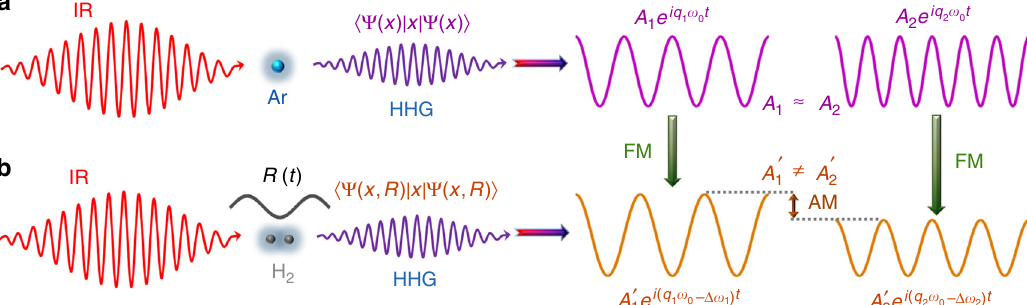
Fig. 1 Sketch of AM and FM in MHOHG. a Schematic diagram of HHG from atoms. The harmonic spectrum generated with atom is composed by series regular odd-order harmonics. For different harmonics ( q 1 and q 2 ) in the plateau region, the harmonic intensities are comparable ( A 1 ≈ A 2 ). b Schematic diagram of HHG from molecules. For molecules, the laser-driven nuclear motion introduces an additional degree of freedom and will modulate the MHOHG. As demonstrated in refs. 27 – 29 , the harmonic intensity in the plateau is approximately proportional to the square of modulus of the nuclear correlation function, which depends sensitively on the traveling time of the electron in the continuum. For different harmonics q 1 and q 2 , the traveling times of the electrons are different, thus leading to an AM in the spectrum ( A ′ 1 ≠ A ′ 2 ). On the other hand, the laser-driven nuclear motion will enhance the ionization rate and thus strengthen the harmonic emission at the trailing edge of the laser pulse. Due to the laser-driven nonadiabatic effect, harmonics dominated at the trailing edge will emerge a FM (red shift) in the spectrum ( q 1 ω 0 → q 1 ω 0 − Δ ω 1 , q 2 ω 0 → q 2 ω 0 − Δ ω 2